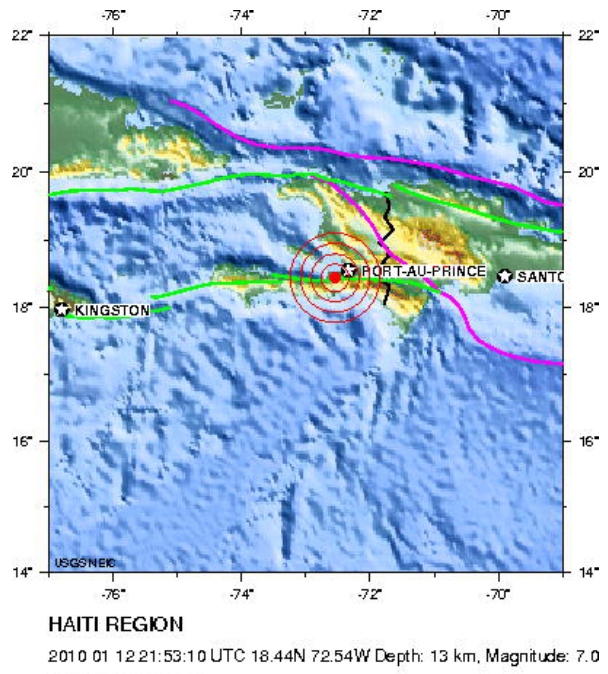
Figure 1b. Epicenter location (source: USGS) Fig. 1b. Epicenter location (source: USGS).